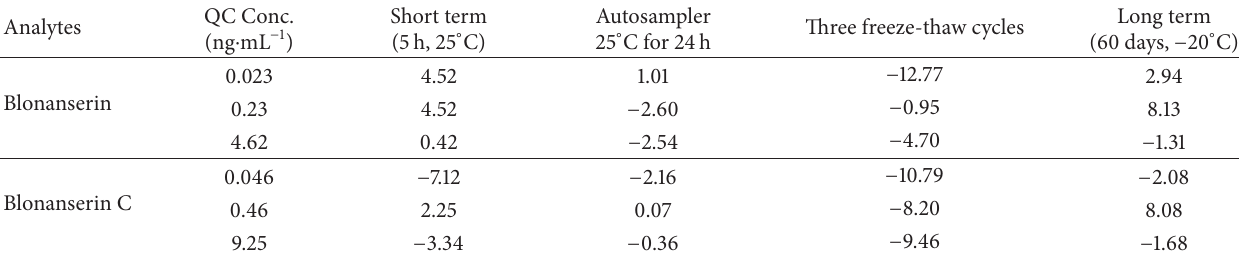
Table 3: Stability of the three analytes in rats plasma under different storage conditions ( 𝑛 = 5 ).